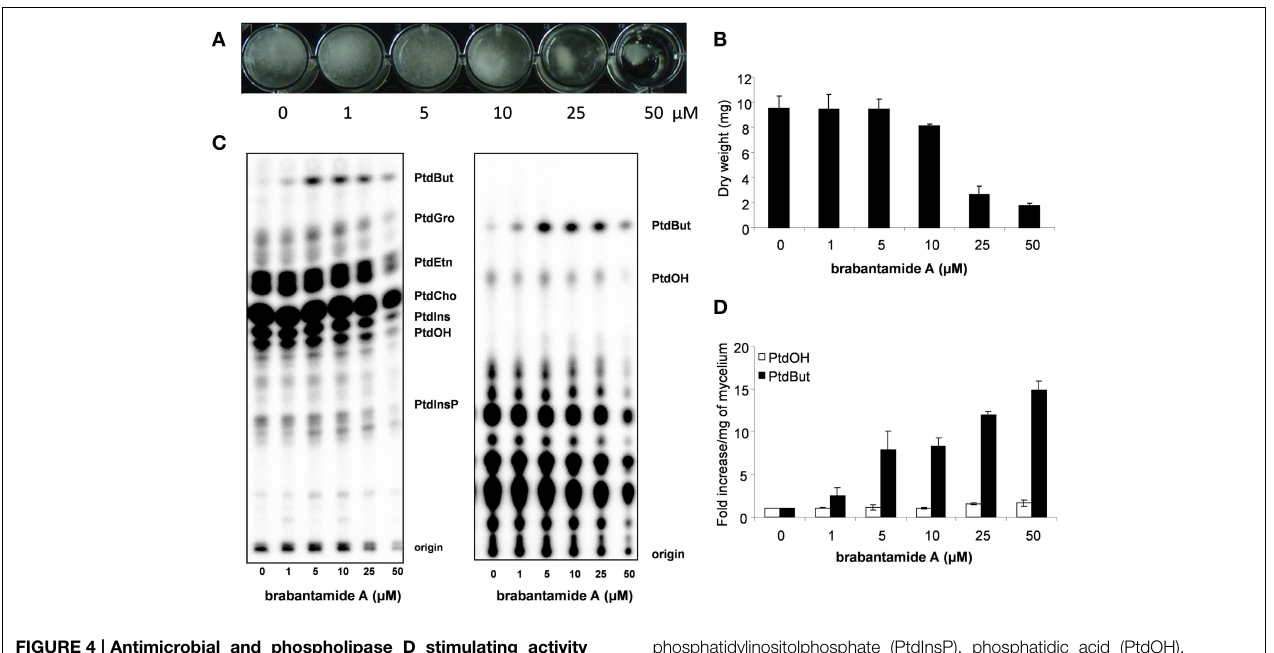
FIGURE 4 | Antimicrobial and phospholipase D stimulating activity of brabantamide A in interaction with Phytophthora infestans . (A) Growth of P. infestans in liquid medium with different concentrations of brabantamide A. (B) Dry weight of P. infestans grown in liquid medium ( n = 2 ). (C) Lipids extracted from P. infestans , separated by alkaline (left) or ethylactetate (EtAc) TLC (right) and analyzed by phosphoimaging. The origin of the chromatogram,